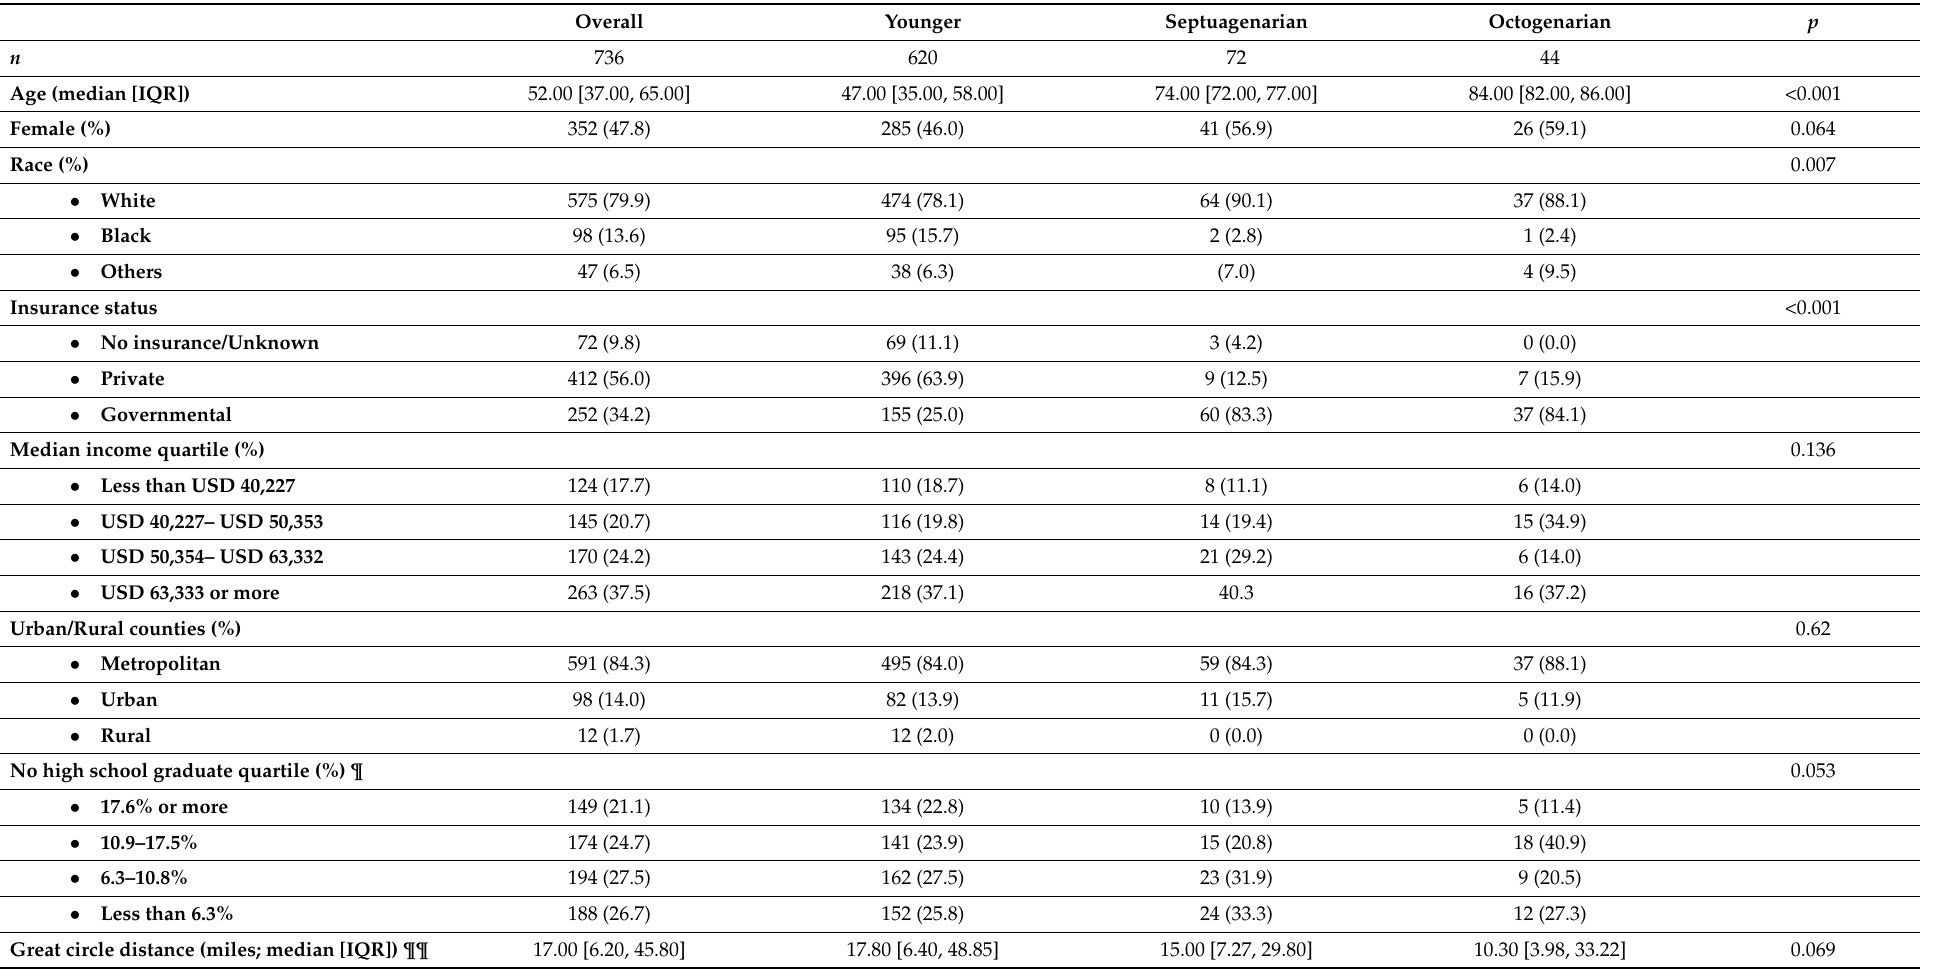
Table 1. Criteria of the included